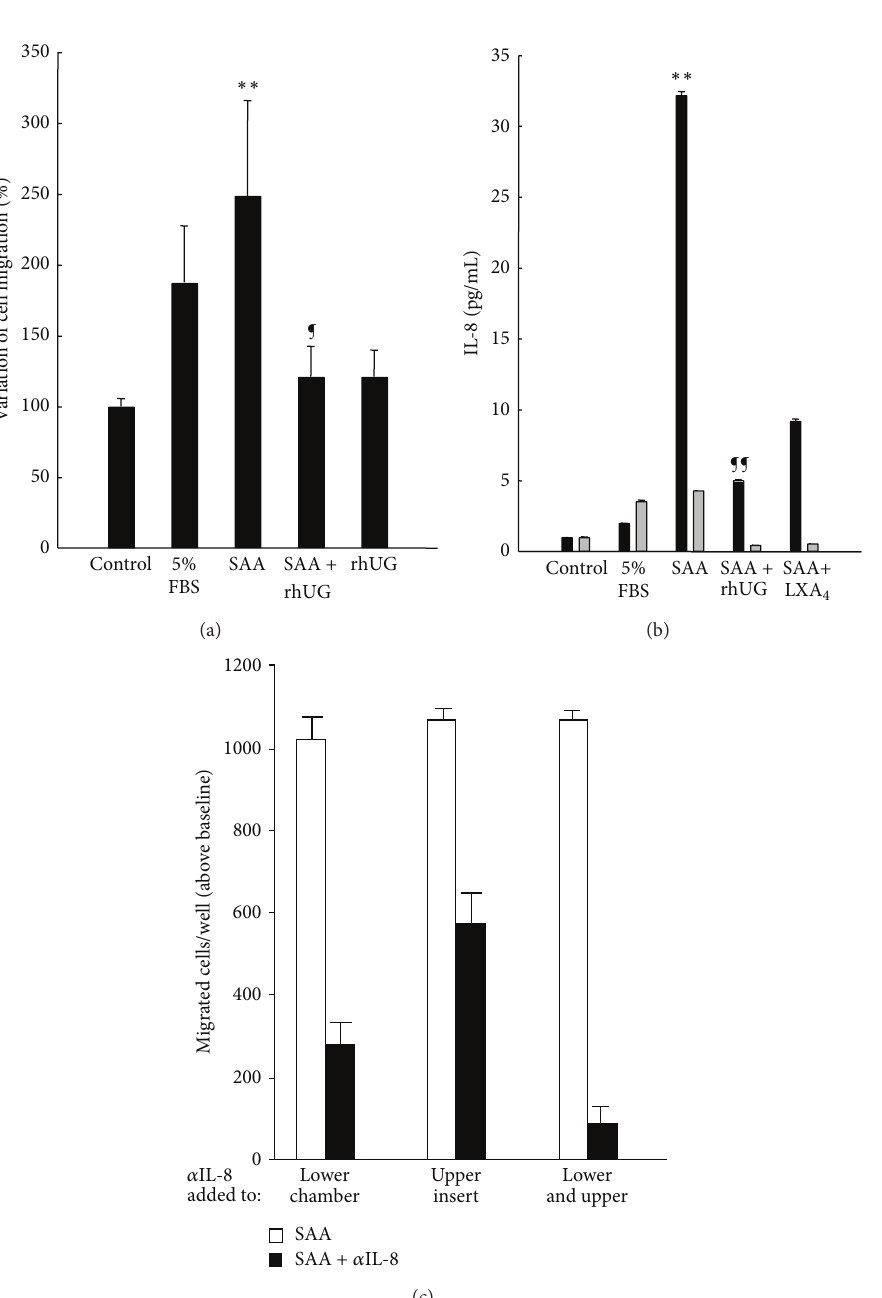
Figure 5: Attenuation of SAA induced cell migration and released IL-8 by hrUG in FLS. (a) Migration of FLS exposed to FBS, SAA (100 nM), or SAA with UG (100nM), shown as % variation above control (basal growth medium). Results are the mean ± SD of three separate experiments with duplicate determinations. (b) Released IL-8 levels as measured by ELISA in the lower and upper chamber medium following FLS treatment with 5% FBS, SAA (100nM) alone or in combination with UG or LXA 4 (both at 100 nM). Results are the mean ± SD of duplicate determinations from two experiments. Data are normalized using cell numbers. (c) Migration of FLS following SAA (100nM) treatment in lower chambers when IL-8 blocking antibody was added to lower, upper, or both compartments of the transwell system. Student’s 𝑡 -test SAA versus control 𝑃 values of < 0.005 ( ∗∗ ) and SAA versus SAA + UG treatments 𝑃 values of < 0.01 (¶) (a) and < 0.002 (¶¶) (b). Results are the mean ± SD from quadruple determinations of two experiments